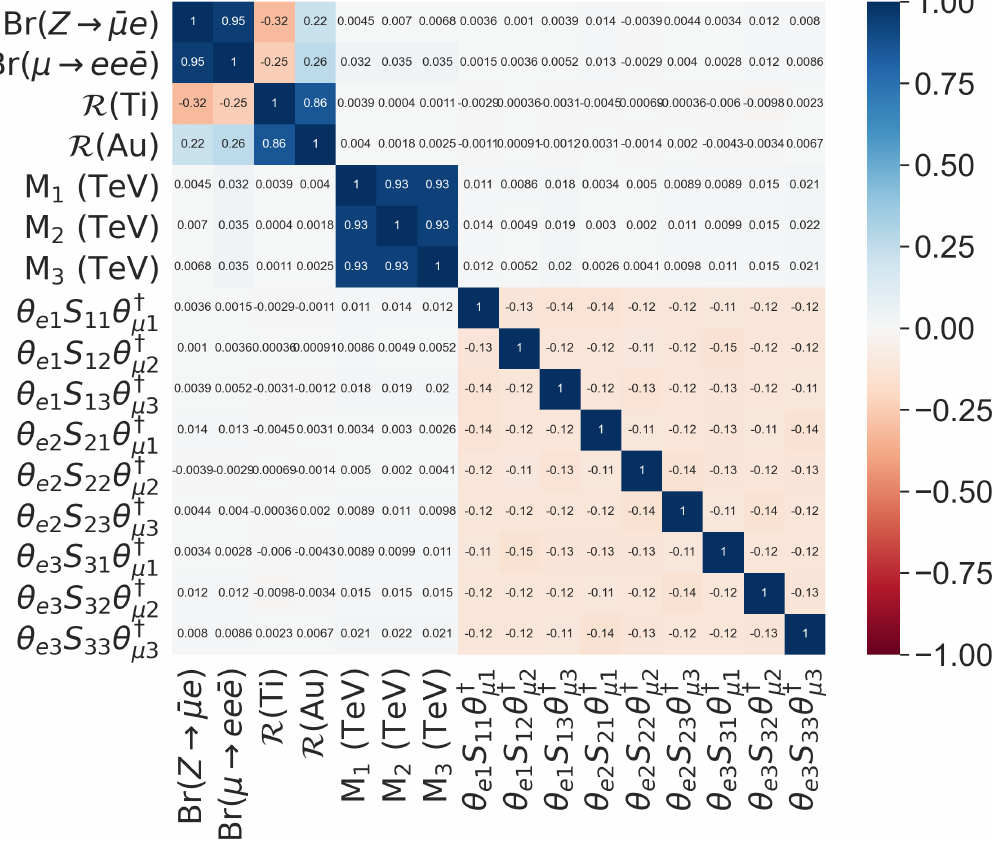
Ti and 197 Au, and their free 22 79